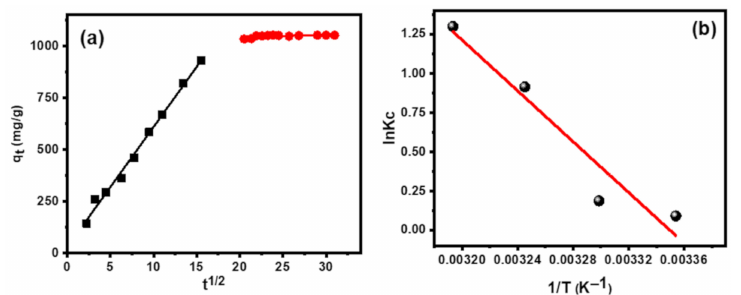
Figure 11. ( a ) Intraparticle di ff usion model, and ( b ) thermodynamic analysis.